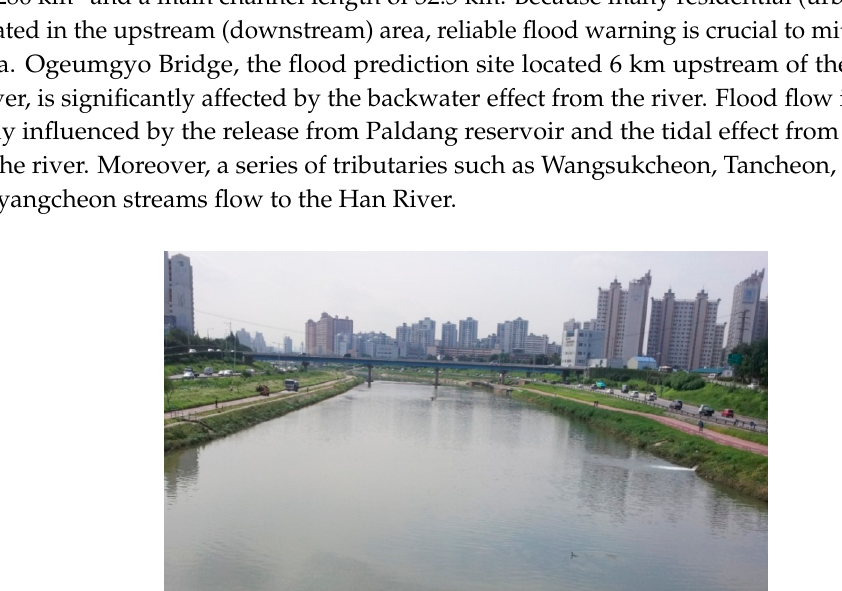
Figure 1. Anyangcheon stream.